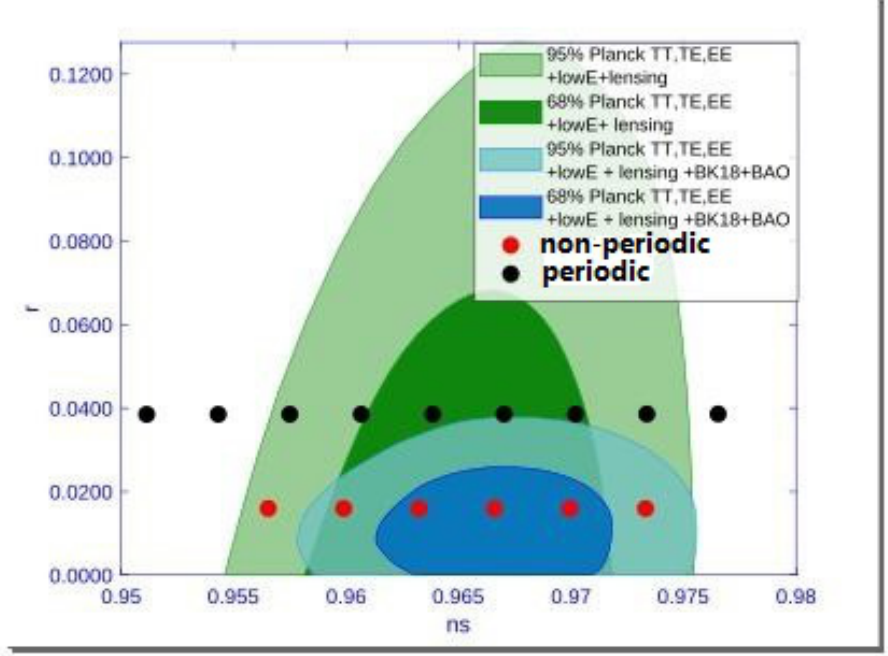
Figure 3. Predictions of warm natural inflation with NMC to gravity in the weak limit. For the quadratic (periodic) NMC in red (black) dots, we took (the values are given in units where Planck mass is unity): Γ 0 = 7.14 × 10 − 7 , f = 2, V 0 = 2.25 × 10 − 15 . We fixed φ ∗ = 2 ( 6.9 ) and scanned over ξ ( λ